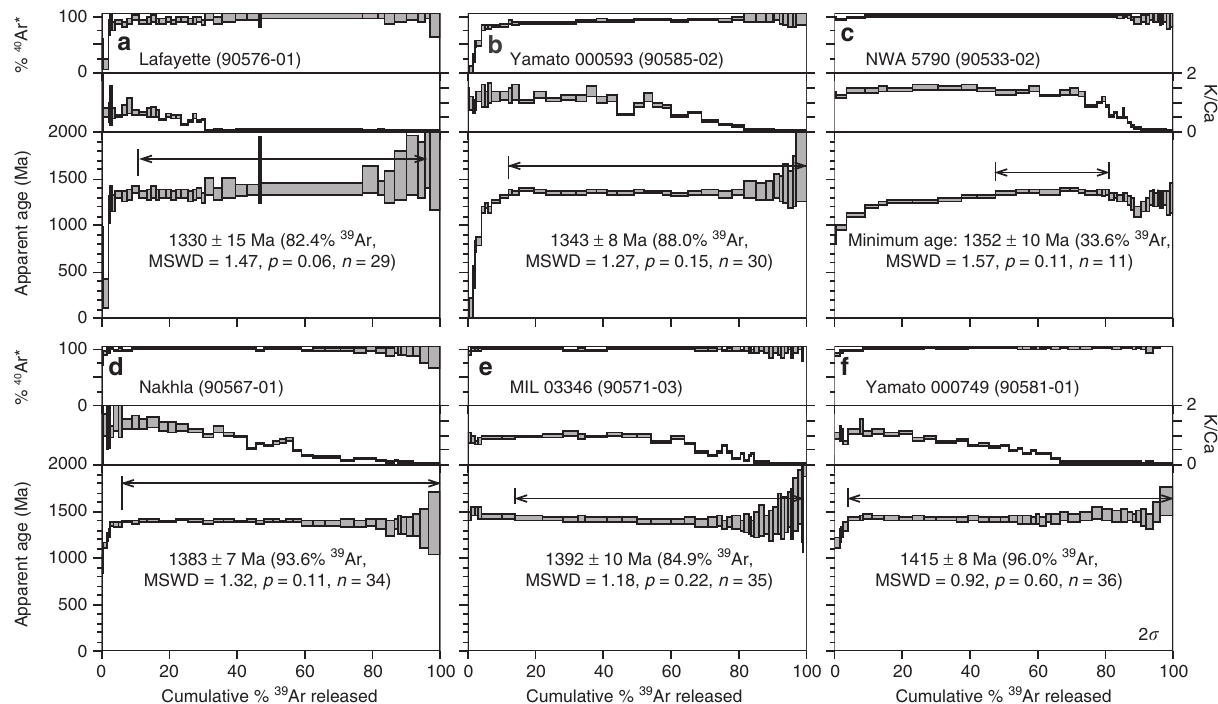
Fig. 5 Representative 40 Ar/ 39 Ar age spectra for the nakhlites. Samples are arranged in chronologic order from youngest to oldest: a Lafayette aliquot 01, b Yamato 000593 aliquot 02, c NWA 5790 aliquot 02, d Nakhla aliquot 01, e Miller Range 03346 aliquot 03 and f Yamato 000749 aliquot 01. The top panel of each sample represents the portion of radiogenic Ar ( 40 Ar*) released from each degassing step; the middle panel represents the K/Ca value for each step; and the lower (main) panel shows the calculated 40 Ar/ 39 Ar age for each degassing step. All uncertainties are 2 σ . The nakhlites yield excellent results, often with statistically robust plateaus comprising > 90% of the 39 Ar released. NWA 5790 c is an exception, with concordant steps spanning only 34% of the 39 Ar released; these results therefore provide only a minimum age constraint for the eruption of this sample. Additional aliquots from these meteorites ( n = 2 to 5) are highly reproducible, with similar degassing spectra and concordant plateau ages (Supplementary Figure